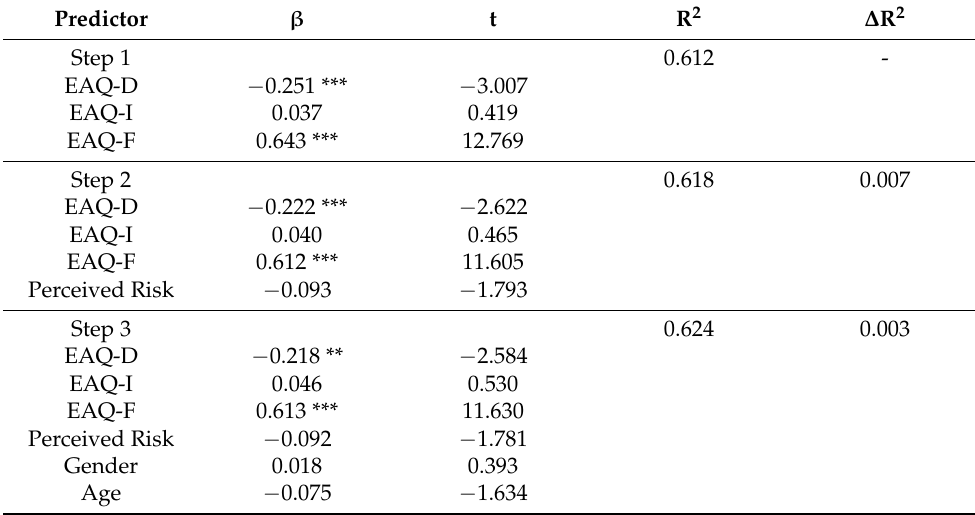
Table 5. Stepwise regression model of the intention to engage in indirect entomophagy ( n = 194). Predictor